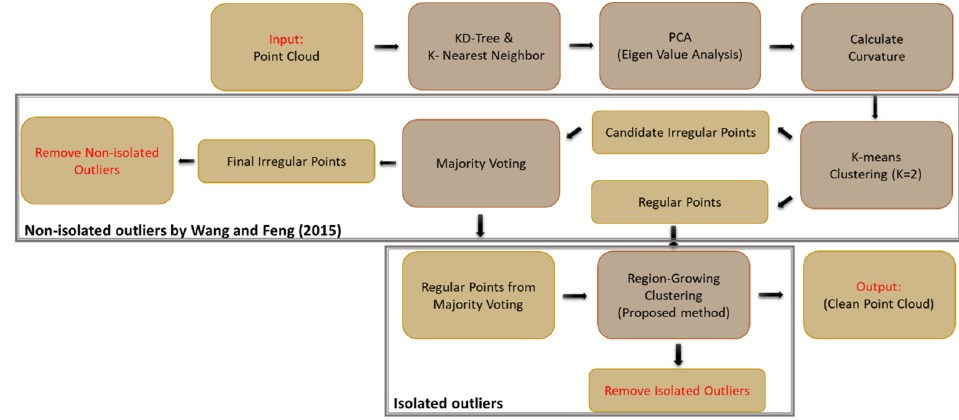
Figure 7. The workflow of geometric outlier detection in two steps; non-isolated outliers were removed by the [5] method, and isolated outliers were removed by a clustering proposed method.